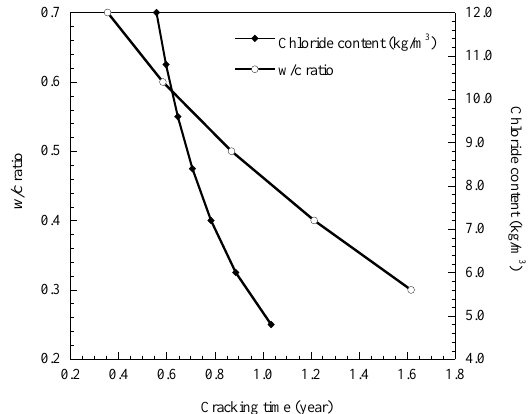
Figure 7. Influence of w/c ratio and chloride content on cover cracking time.